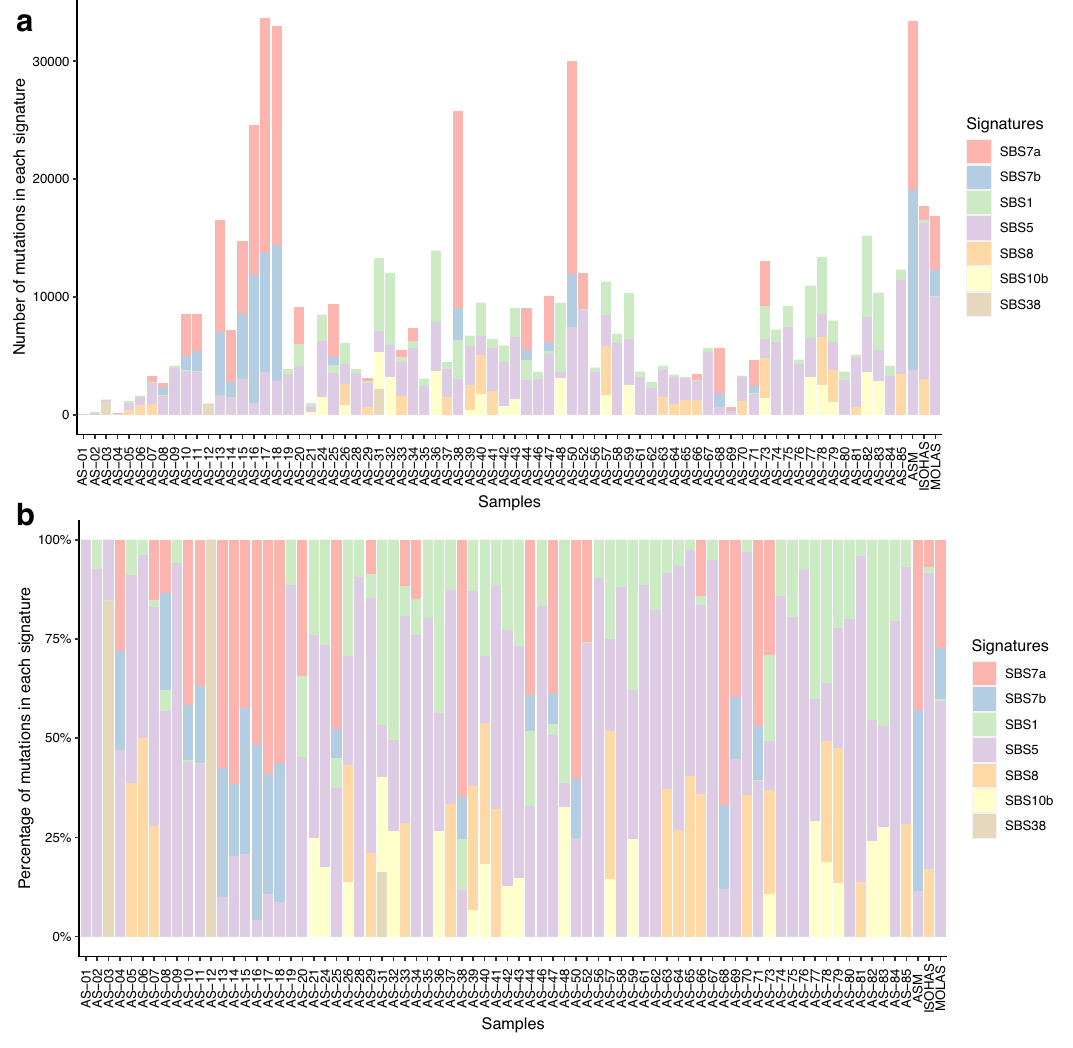
Fig. 2 Mutational signatures of head and neck angiosarcoma. AS-HN harbored distinctive UV-related mutational signatures (COSMIC Mutational Signatures 7a and 7b) in 23 cases (SBS 7a and/or 7b, 52.3%). Mutations in each signature per sample are shown by ( a ) absolute number and by ( b ) proportion. Other mutational patterns identi fi ed included SBS 1, SBS5, SBS38, and SBS